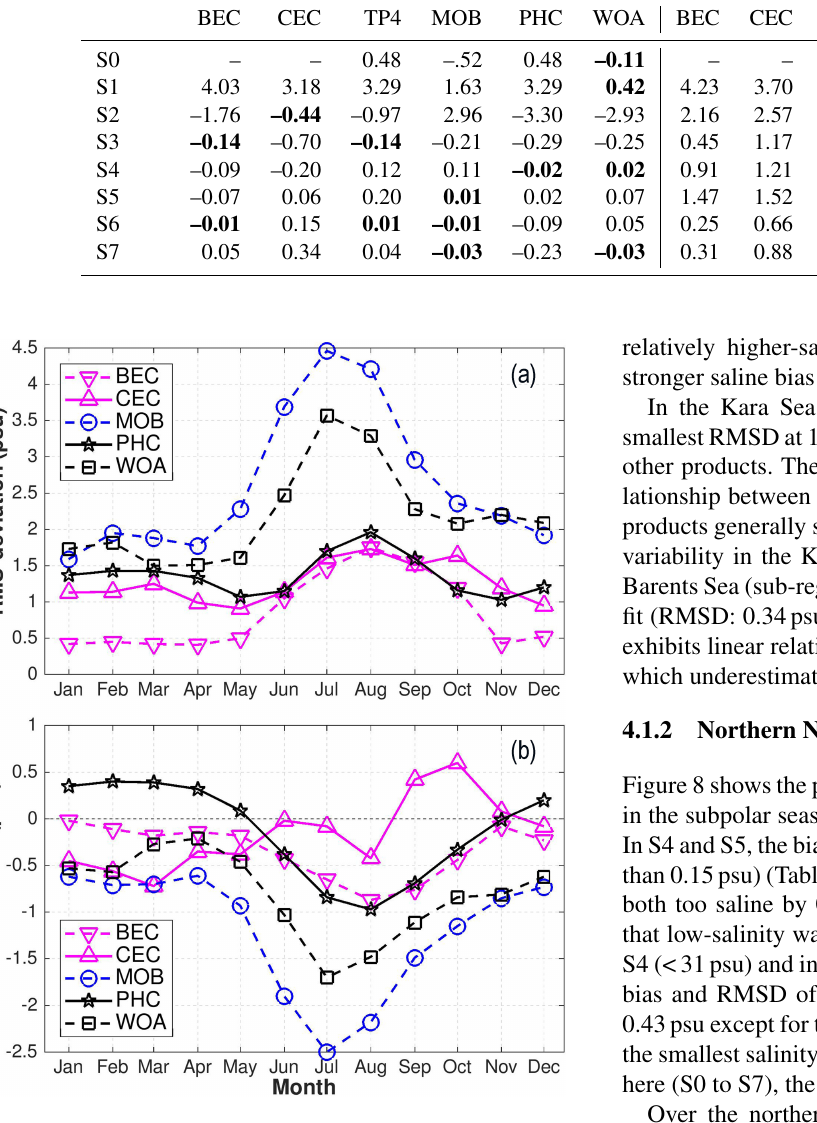
Figure 6. Monthly deviations in the Arctic Ocean (>60 ◦ N) of (a) the rms and (b) the spatial average during the period 2011–2013 for the five SSS products referenced to TP4. The lines with inverted triangle, triangle, circle, star, and square represent the SSS devia- tions from BEC, CEC, MOB, PHC, and WOA,